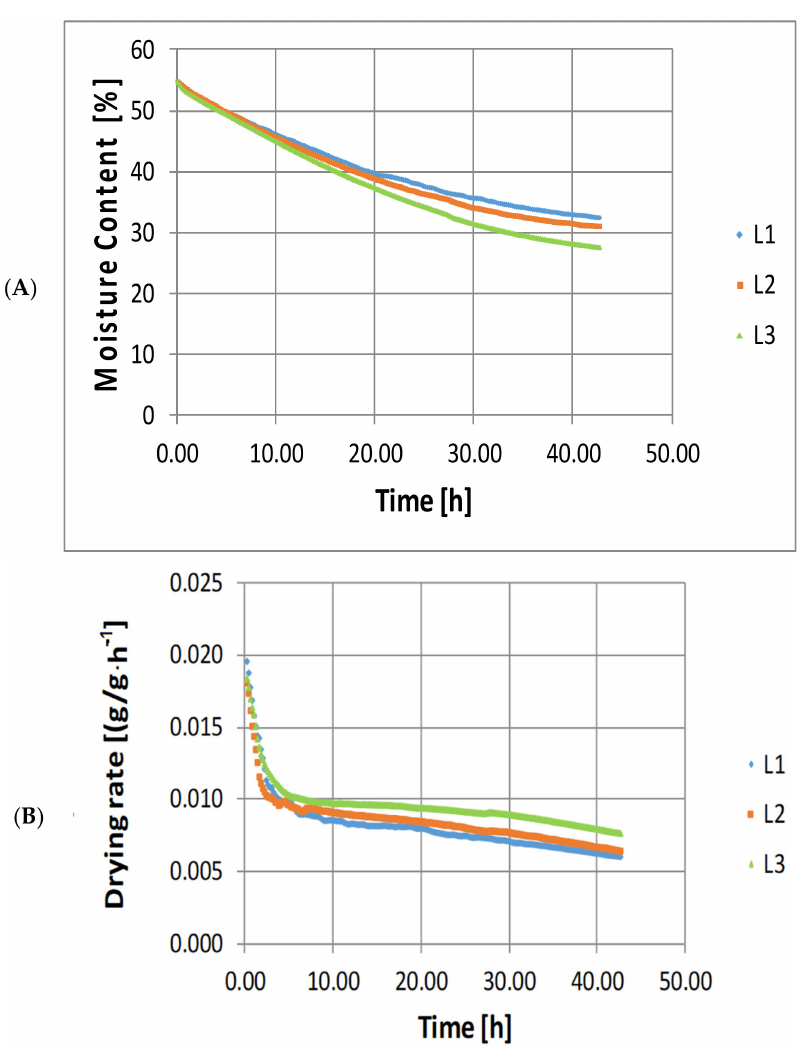
Figure 5. Curves of moisture content MC t ( A ) and drying rate DR t ( B ) as a function of time for laurel dehydration process. Data are means of three replications (L1 = 3 kg / m 2 , L2 = 4 kg / m 2 and L3 = 5 kg / m 2